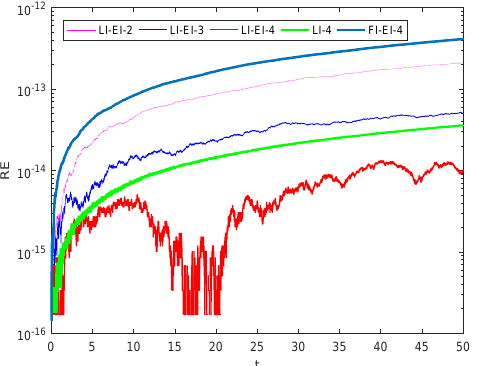
Figure 2. The relative modified energy errors with T = 50, α = 1.8, τ =